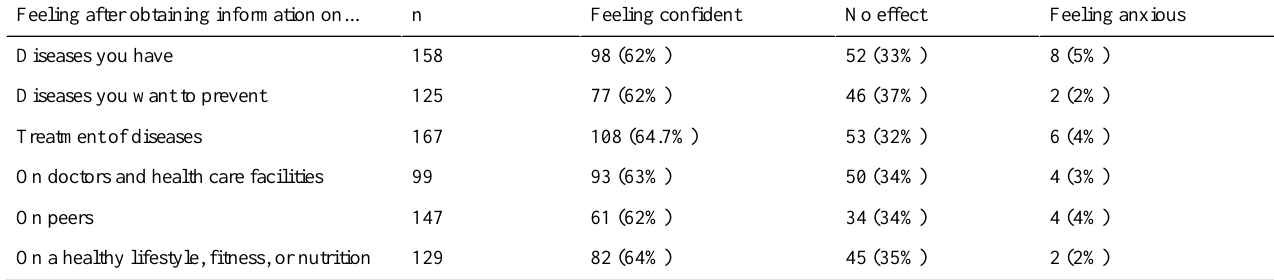
Table 6. Perceived effects of Internet use on feelings of confidence and anxiety among Internet users